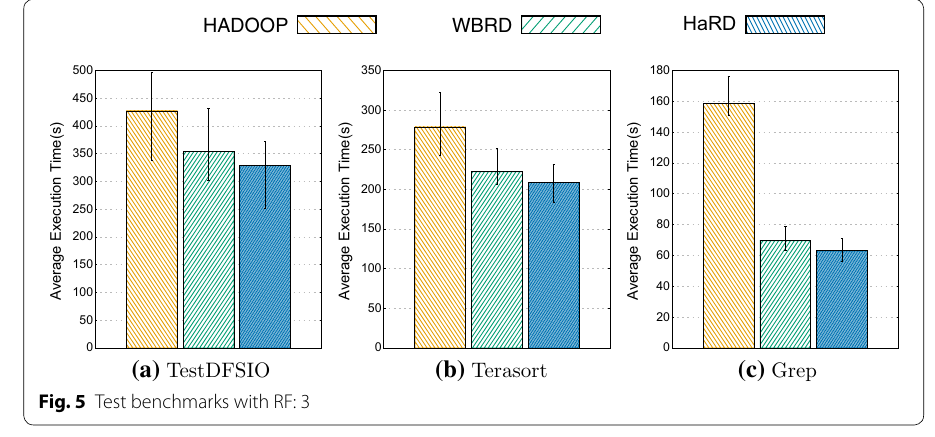
Fig. 5 Test benchmarks with RF: 3